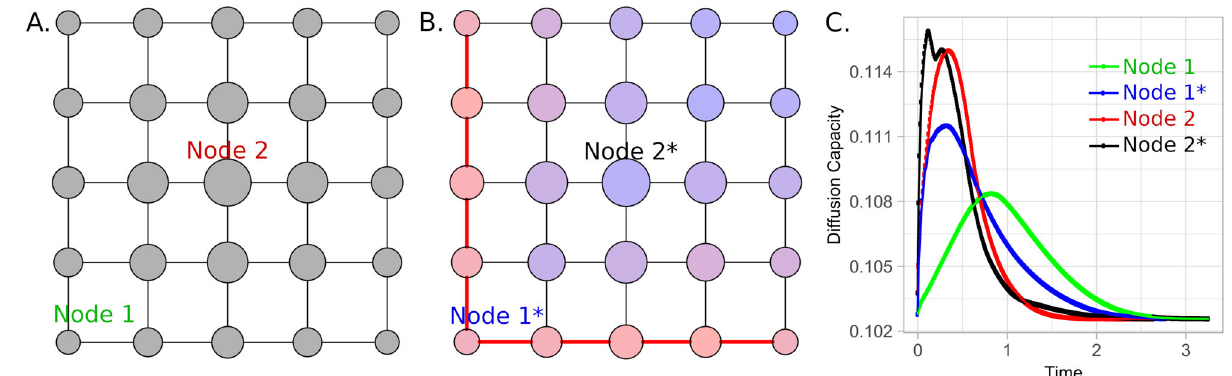
Fig. 7 | Regular grid in which the size of the nodes correspond to their topo- logical diffusion capacity. A and the topological diffusion capacity when some peripherallinkspossessahigherweight( B ).Twodifferentheatdiffusionprocesses are initiated in nodes 1 or 2 in both structures by assigning a temperature 25